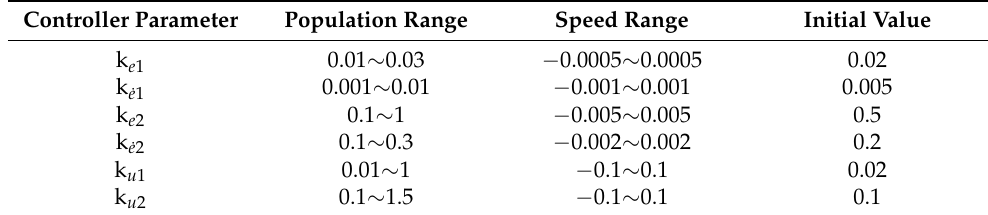
Table 7. Parameters of the adaptive fuzzy controller (this